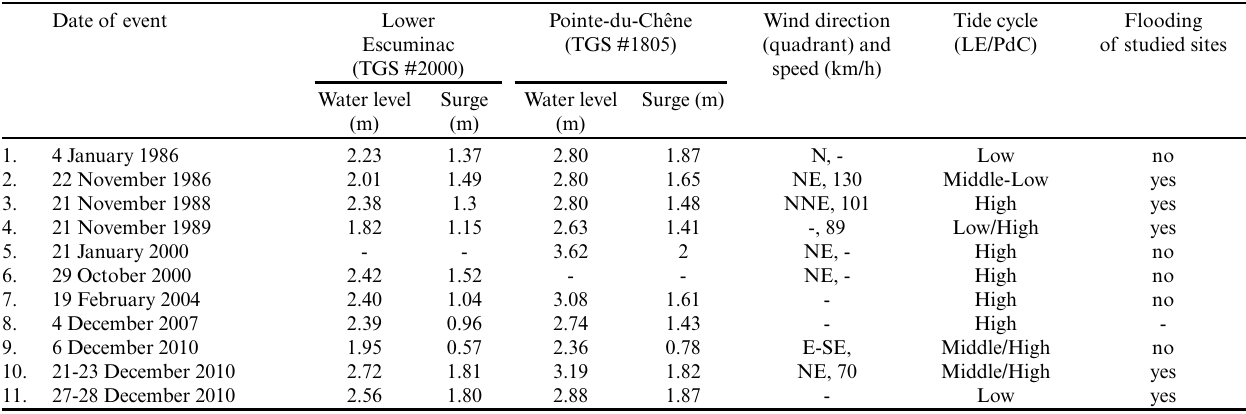
Table 2 . Characteristics of the 11 fall/winter storms selected for this study, including maximum water level (MWL), storm surge height and tide cycle at time of MWL, wind direction/speed, and presence/absence of flooding. Location of tide-gauge stations is shown in Figure 1. Date of event Lower